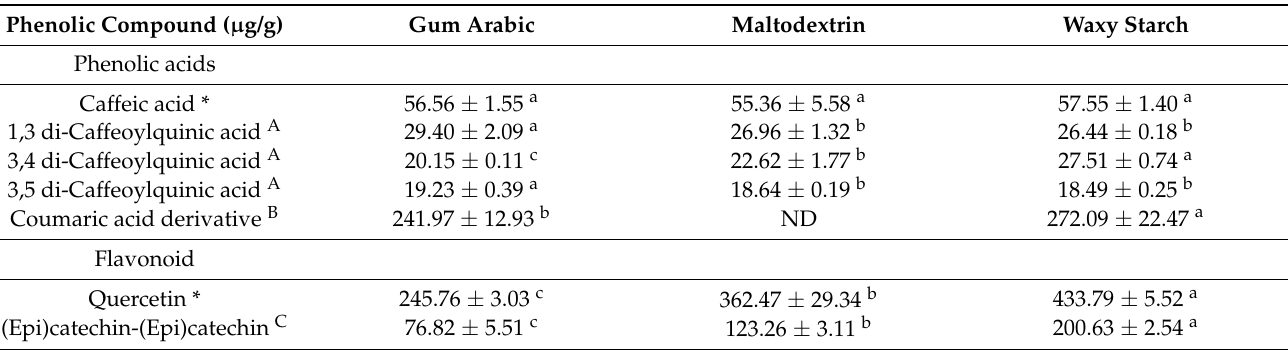
Table 3. Concentration of selected phenolic compounds from the freeze-dried passion fruit peel powders developed using different